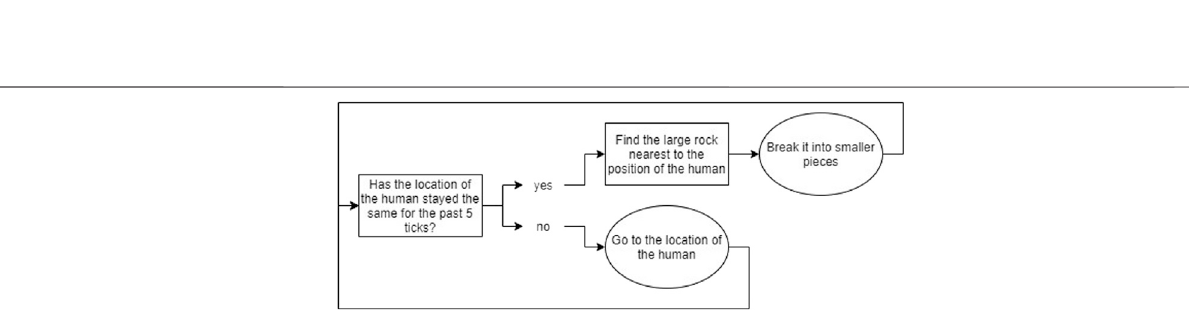
Frontiers in Robotics and AI |